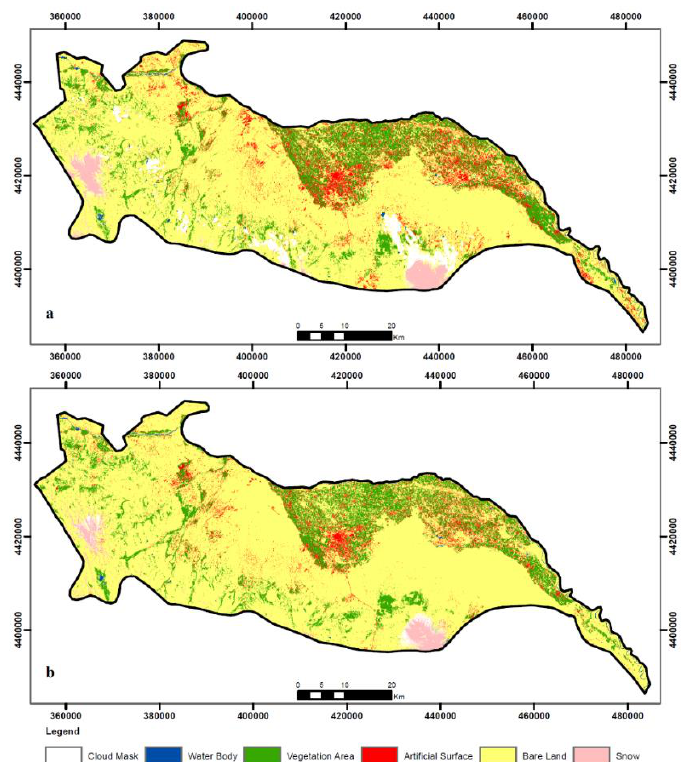
Figure 4. LULC image maps of the interested area; a) Landsat 8 derived LULC, b) Landsat 9 derived LULC. Table 1 represents the accuracy assessment report for the Considering the comparison of TIR sensors, Figure 5 represents LULC of the Landsat 9 image had a higher kappa value (0.83) the LST results from both Landsat images and